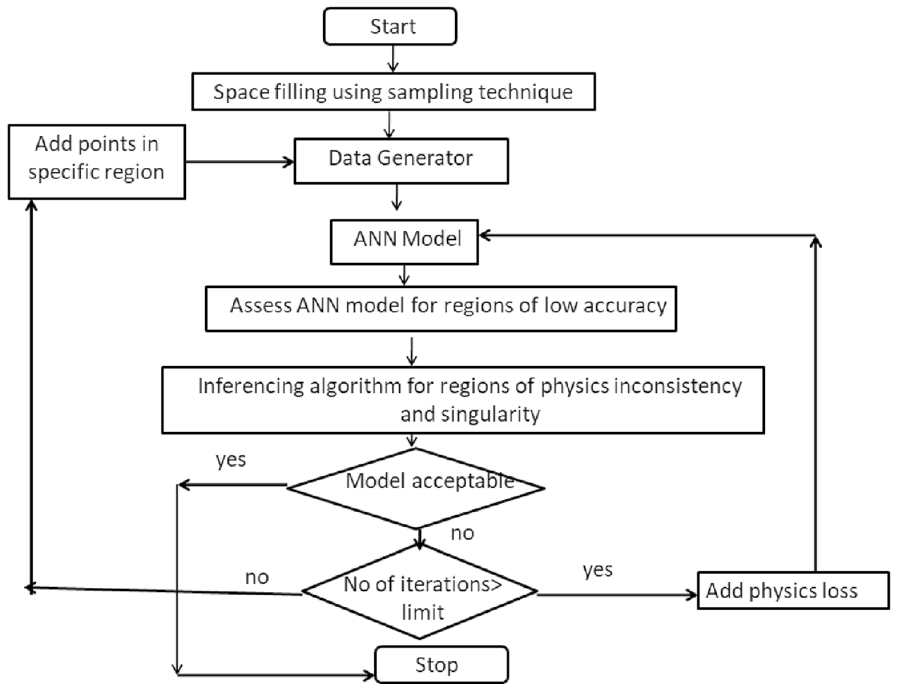
Fig. 2 Flowchart for proposed methodology for developing physics consistent ANN